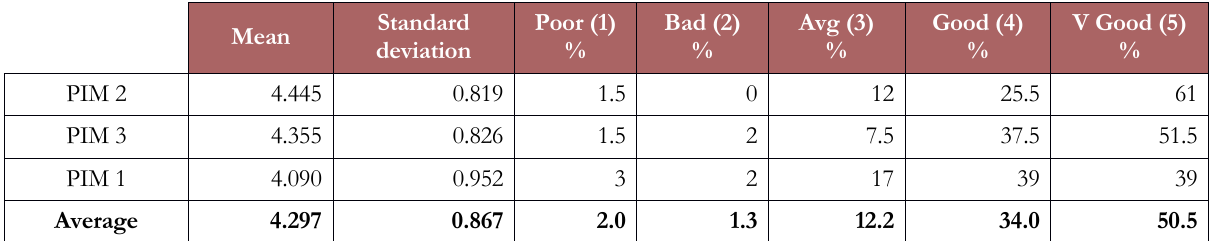
Table 12. Process improvement factor responses